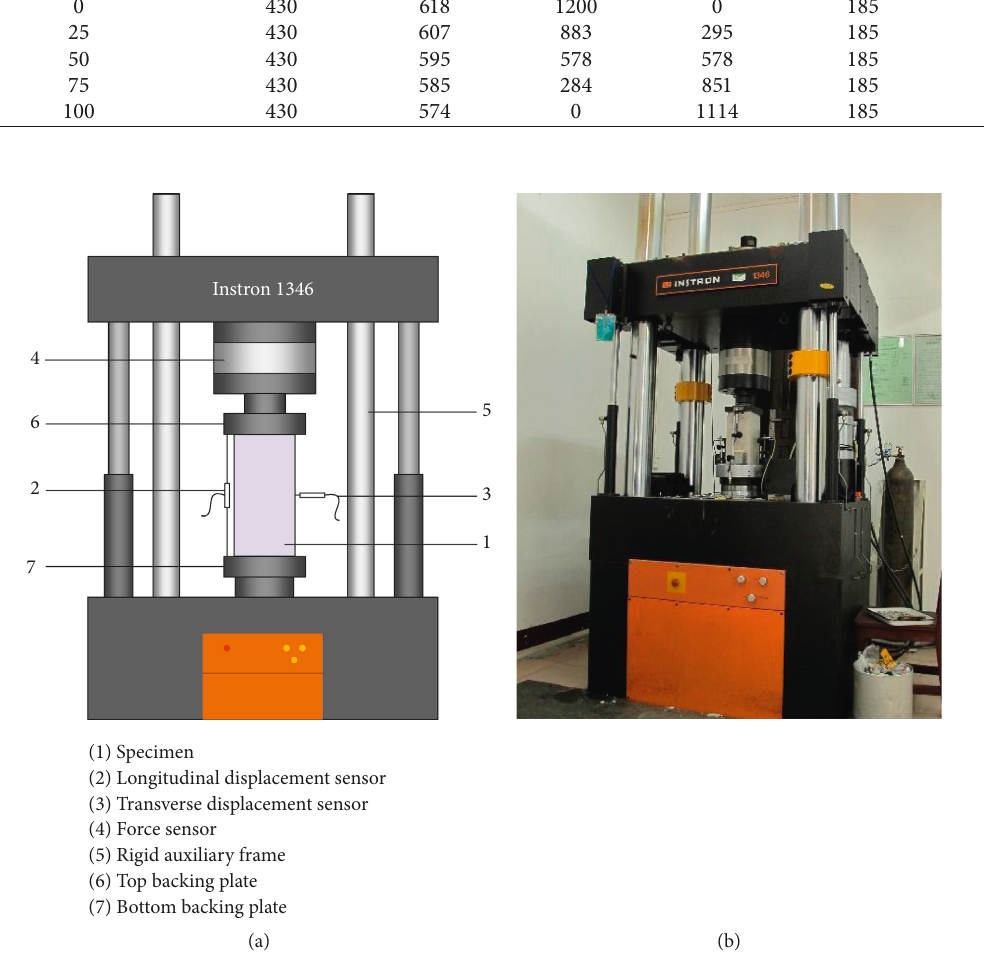
Figure 2: Test setup. (a) Schematic diagram. (b) Test